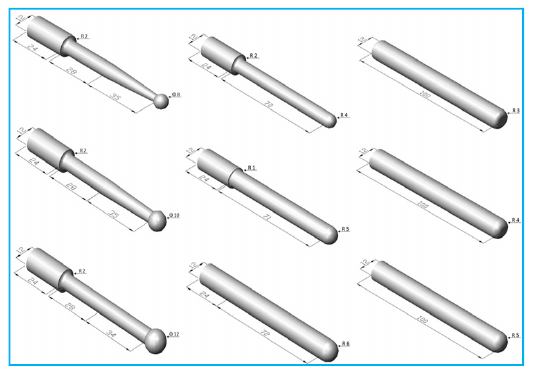
Fig. 5. The tools used.